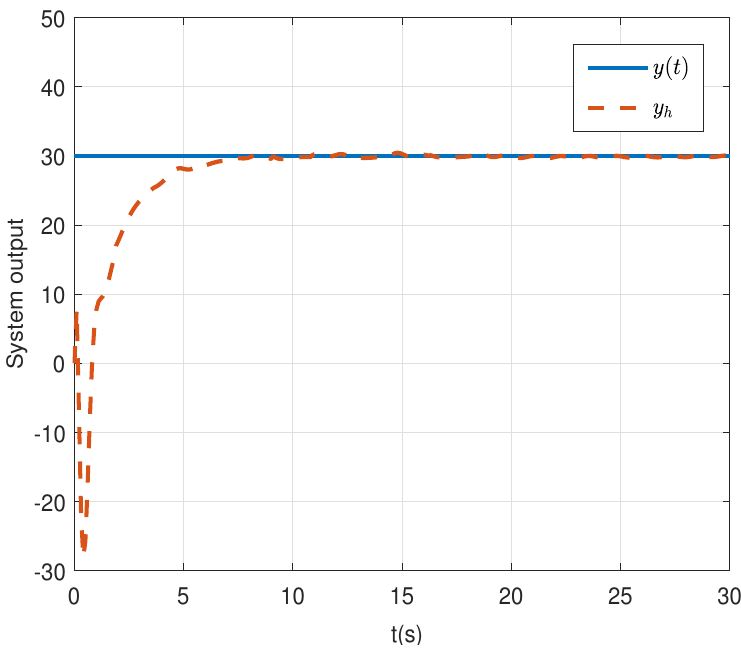
Figure 4. Trajectory of system